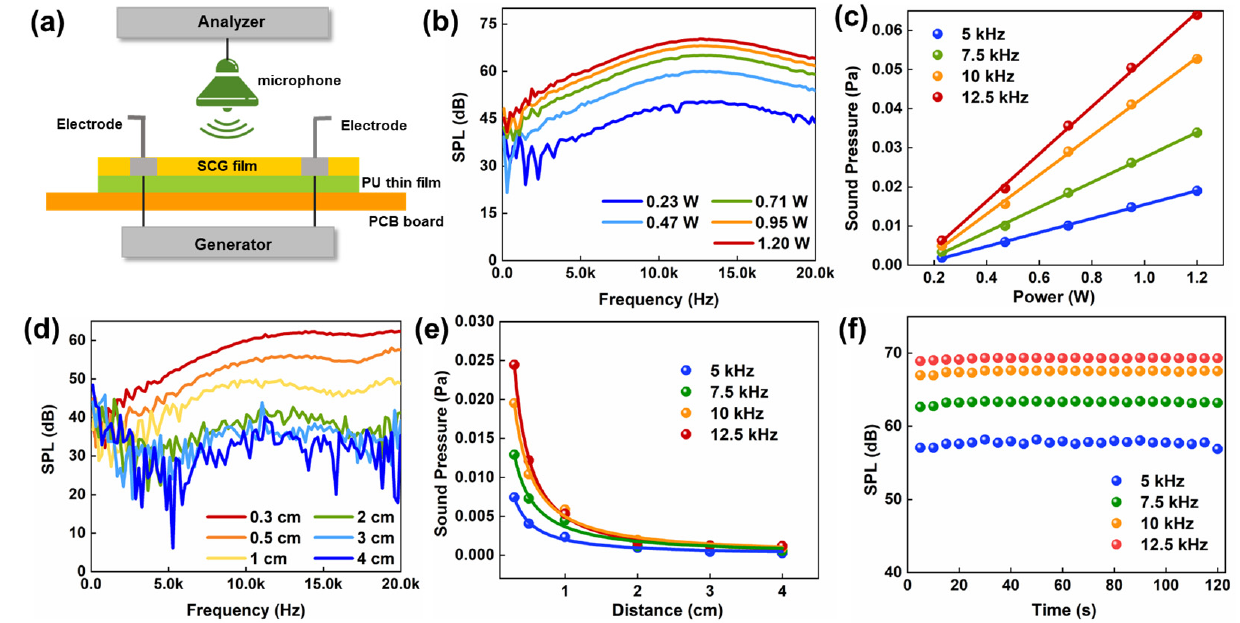
Figure 6. The performance of emitting sound. ( a ) Schematic structure of the device and the schematic diagram of the test platform. ( b ) The SPL responds to different powers. (d = 0.3 cm). ( c ) The output SP versus the input power at 5, 7.5, 10, and 12.5 kHz. ( d ) The SPL response at different test distances. ( e ) The output SP versus the test distance at 5, 7.5, 10, and 12.5 kHz. ( f ) The stability of the output SPL for 120 min and each test for 5 min measurements at 5 kHz, 7.5 kHz, 10 kHz, and 12.5 kHz.